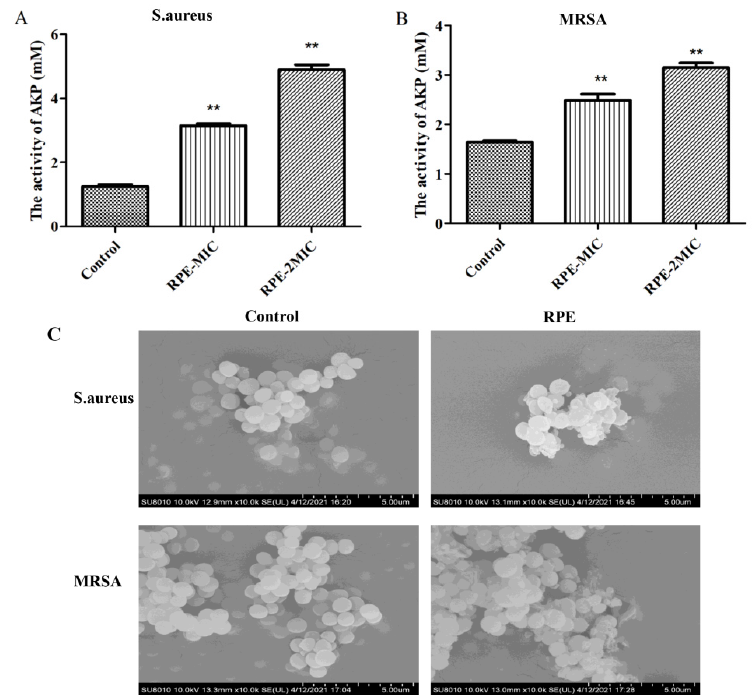
Figure 4. Assessment of leakage of AKP from ( A ) S. aureus and ( B ) MRSA treated with RPE; and ( C ) scanning electron micrographs of S. aureus and MRSA treated with RPE. Scanning electron micrographs show cell wall integrity of S. aureus : ( left ) S. aureus control (magnification × 100,000); ( right ) S. aureus treated with the RPE at 100 µ g/mL (magnification × 100,000); Scanning electron micrographs showing cell wall integrity of MRSA: ( left ) MRSA control (magnification × 100,000); ( right ) MRSA treated with the RPE at 100 µ g/mL (magnification × 100,000). All data are presented as mean values ± SD, and n = 3 in each group. ** p < 0.01, vs. the solvent control.